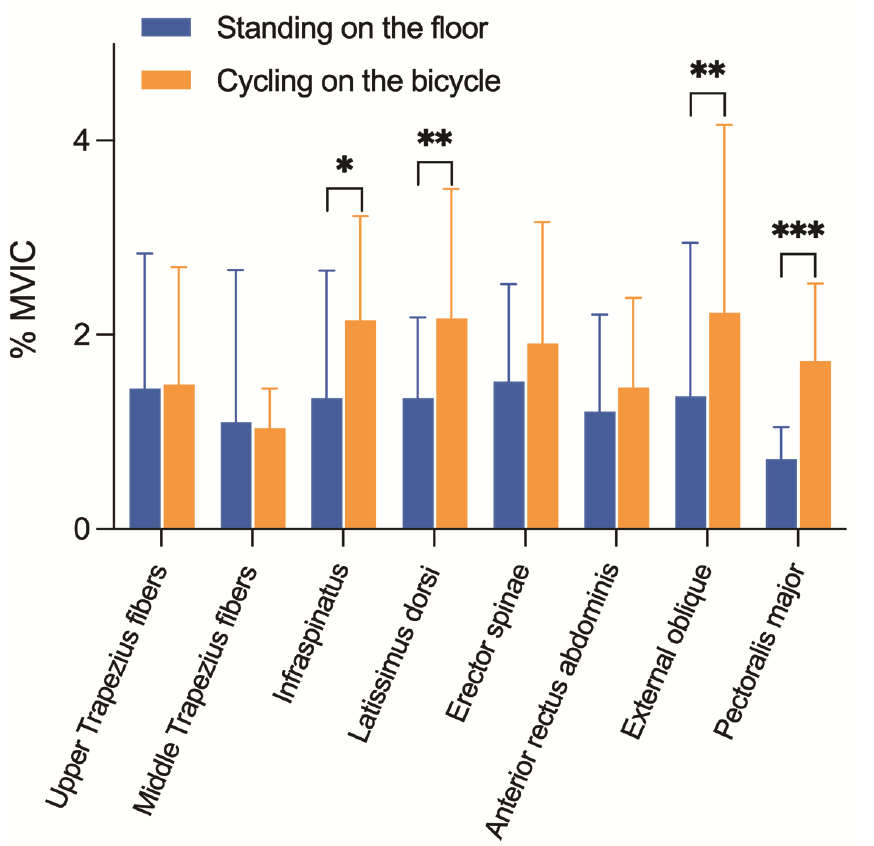
Figure 4. Comparison of the muscle activity, expressed as a percentage of the maximal voluntary isometric contraction (% MVIC), in a standing position versus on the bicycle. * p < 0.05; ** p < 0.01;